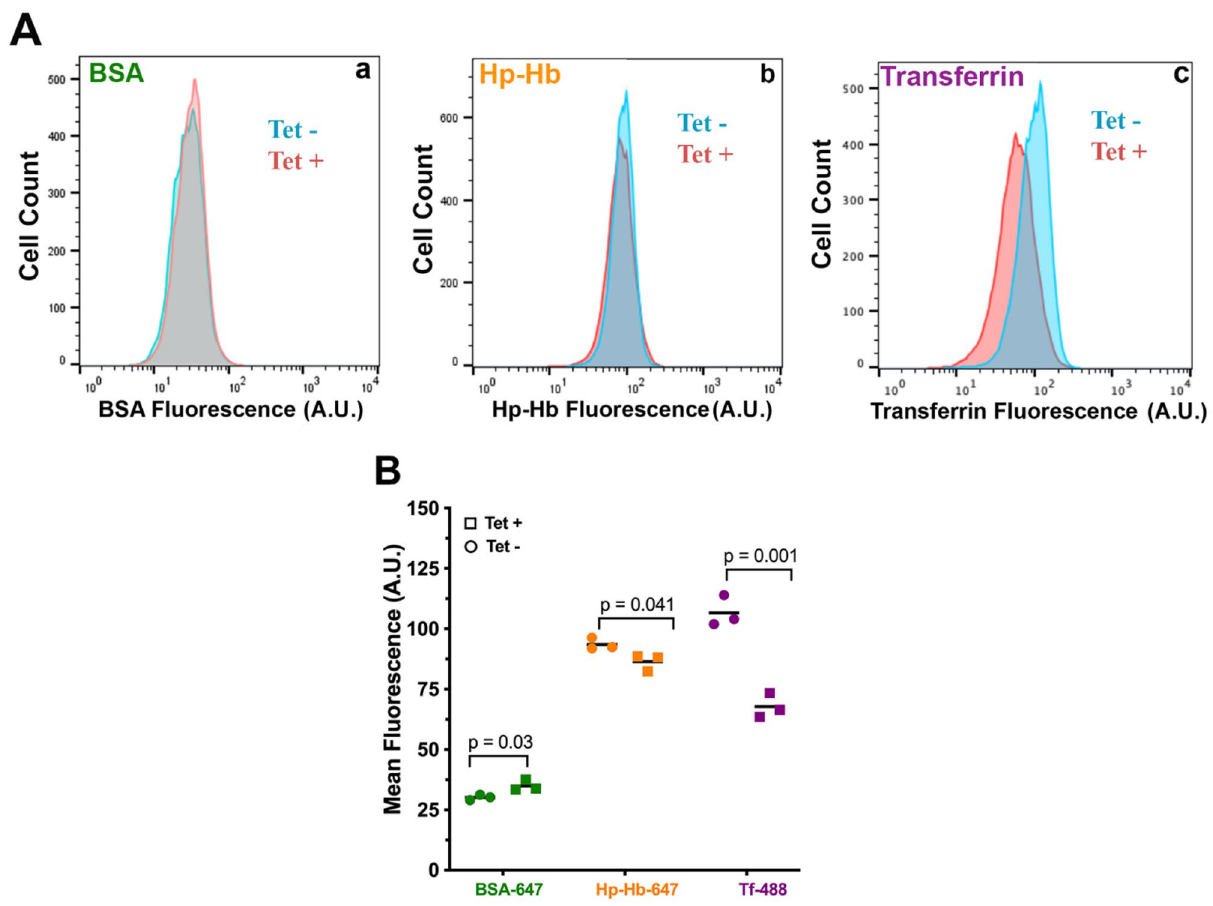
Figure 2. TbNRP1 selectively regulates transferrin endocytosis. Knockdown of NRP1 was induced for 6 h with 1 µg/mL tetracycline. Cells were incubated with BSA-Alexa647 (25 µg/mL), Hp-Hb-Alexa647 (30 µg/mL) or Transferrin-Alexa488 (25 µg/mL) for 15 min at 37 °C. Fluorescence was analysed with flow cytometry. ( A ) Representative histograms of fluorescence intensity in uninduced (Tet-) and induced (Tet+) cells for BSA- Alexa647, Hp-Hb-Alexa647 and Transferrin-Alexa488, respectively. ( B ) Quantitation of mean fluorescence of BSA-Alexa647, Hp-Hb-Alexa647 and Tf-Alexa488 in uninduced (Tet-) and induced (Tet +) cells (n = 3). p